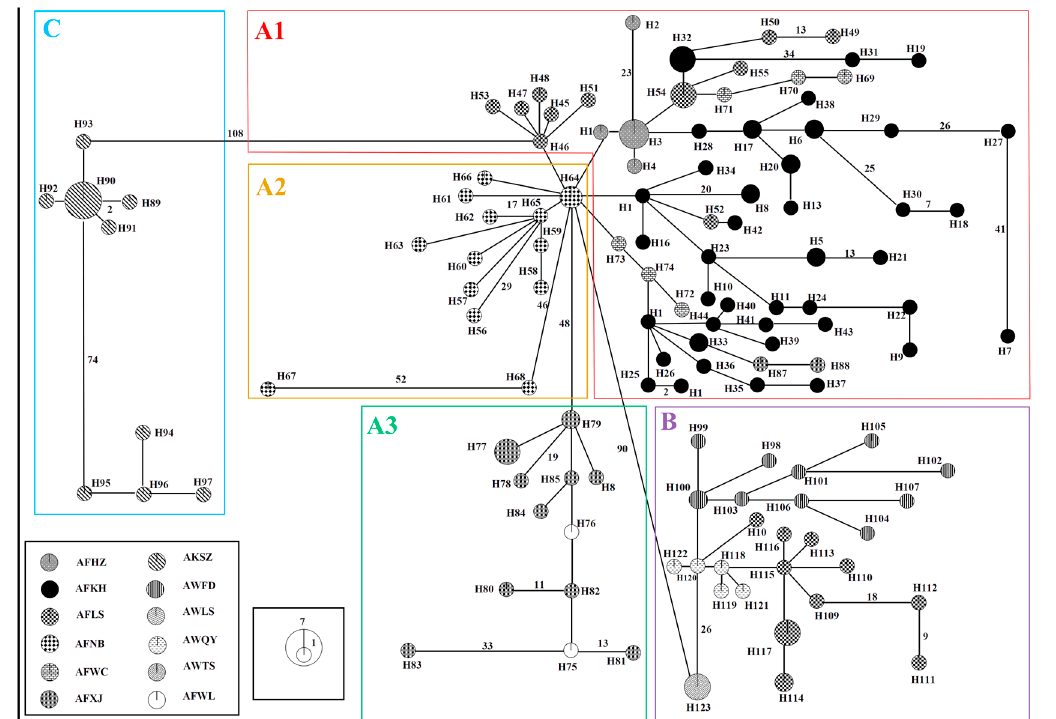
Figure 4. Minimum spanning network (MSN) based on mutations between haplotypes observed in populations of three Acrossocheilus species. Haplotype designations (Table 1) are indicated next to each circle. Locality designations (see Figure 1) for specimens possessing each haplotype are indicated inside the circles. The sizes of the circles are proportional to the number of individuals represented. The length of the lines between circles is roughly proportional to the estimated number of mutational steps between the haplotypes. Clades ( A )–( C ) is shown on the map with corresponding colors for each lineage.